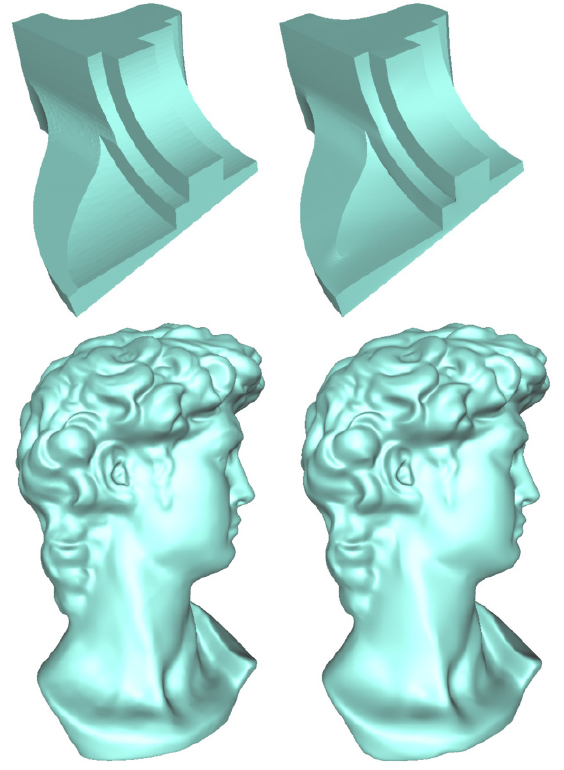
Fig. 7 Reconstruction results. Left: input models. Above: Fandisk with 750 vertices. Below: head of David with 195,760 vertices. Right: reconstructed subdivision surfaces, using 152 and 1583 control points